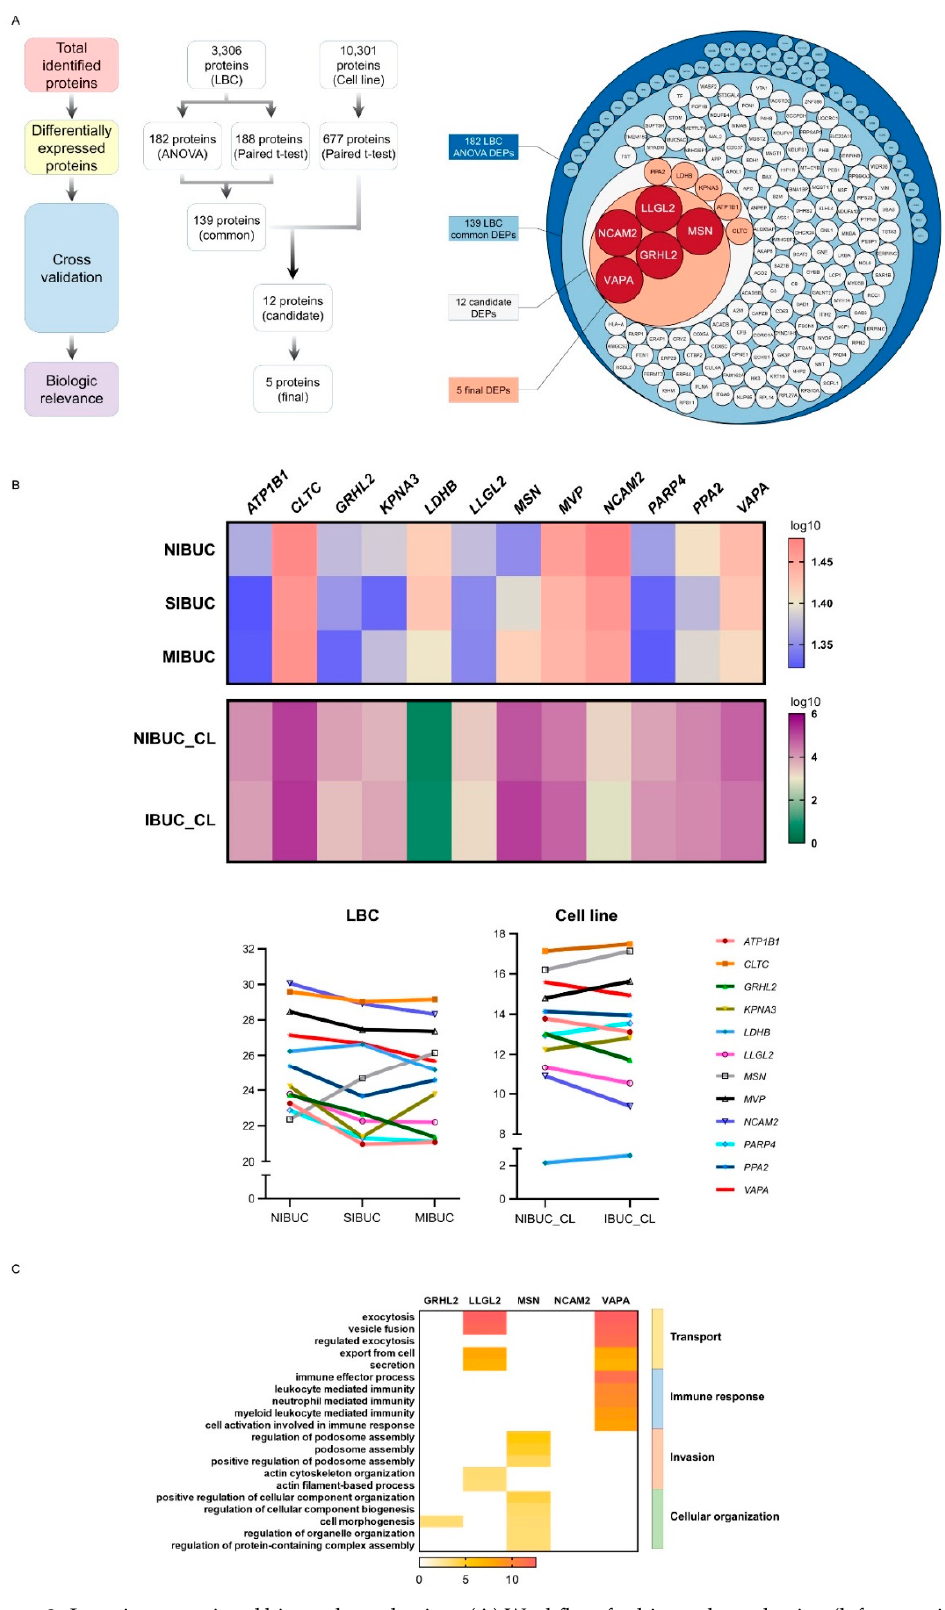
Figure 3. Invasion-associated biomarker selection. ( A ) Workflow for biomarker selection (left, overview; right, circlepack). ( B ) Intensity tendency of candidate biomarkers in BUC LBC and cell line proteomics (left, heatmap; right, broken-line graph). ( C ) Gene ontology results of final five candidate biomarkers.